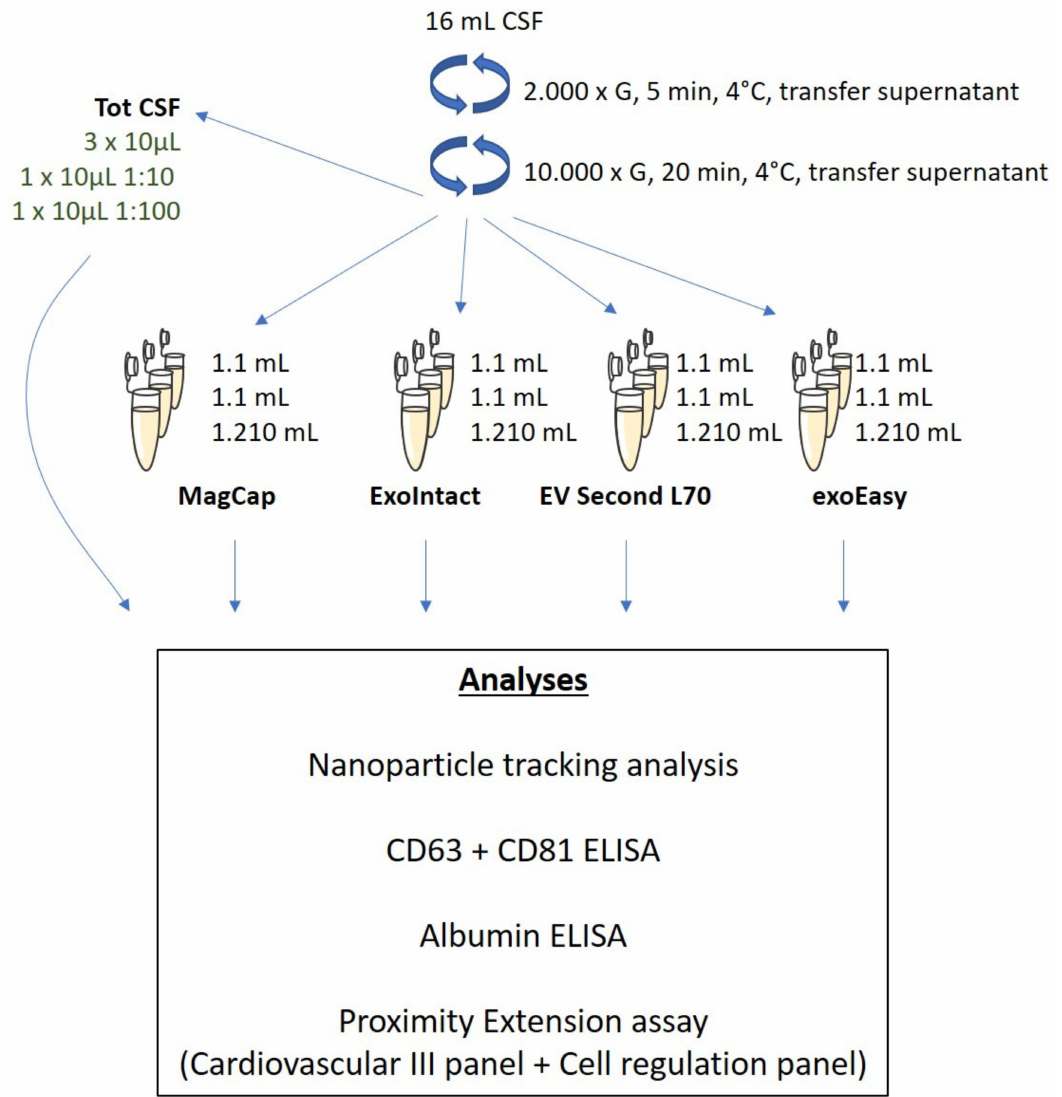
Figure 1. Study overview. Pooled cerebrospinal fluid (CSF) from healthy volunteers was cleared using sequential centrifugation. Extracellular vesicles (EVs) were isolated using four di ff erent commercially available kits. The isolated EVs were characterized by nanoparticle tracking analysis, ELISA, and proximity extension assay. Tot CSF: total CSF, MagCap: